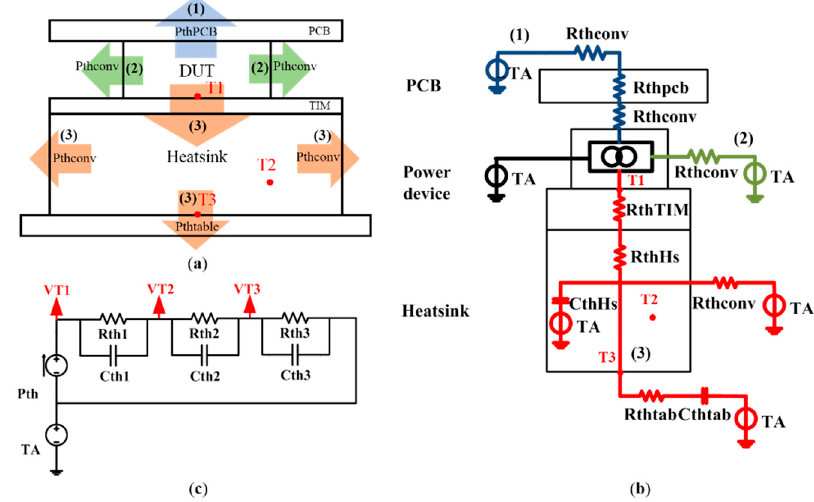
Figure 1. ( a ) Schematic diagram of DUT with heat sink; ( b ) thermal model of DUT with heat sink; ( c ) simplified thermal-circuit model of DUT with heat sink.